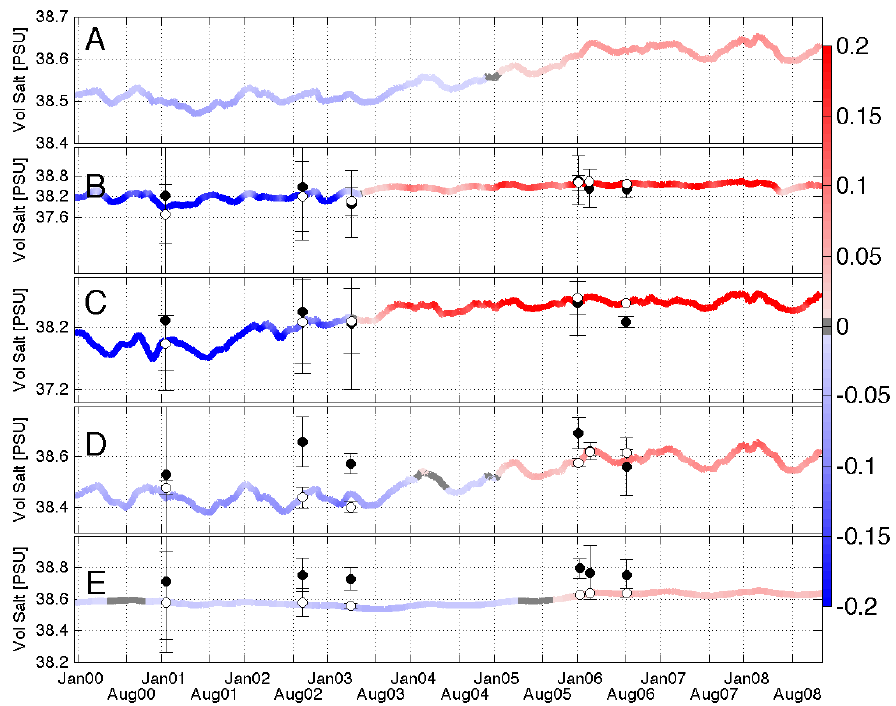
Fig. 9. Monthly time series of volume averaged salinity, units are PSU. Colour indicates monthly anomaly values. (A) : whole Adriatic Sea; (B) : WACC region; (C) : Northern Adriatic Region; (D) : Middle Adriatic Region; (E) : Southern Adriatic Region. In panels (B, C, D) and (E) dots indicate the vertically- and spatially-averaged values of observations (black dots) and model results (white dots). Dates of the sampling are listed in Table 1; positions of the sampling are displayed in Fig. 1. The model results were sampled in the same position and at the same time as the observation before averaging.